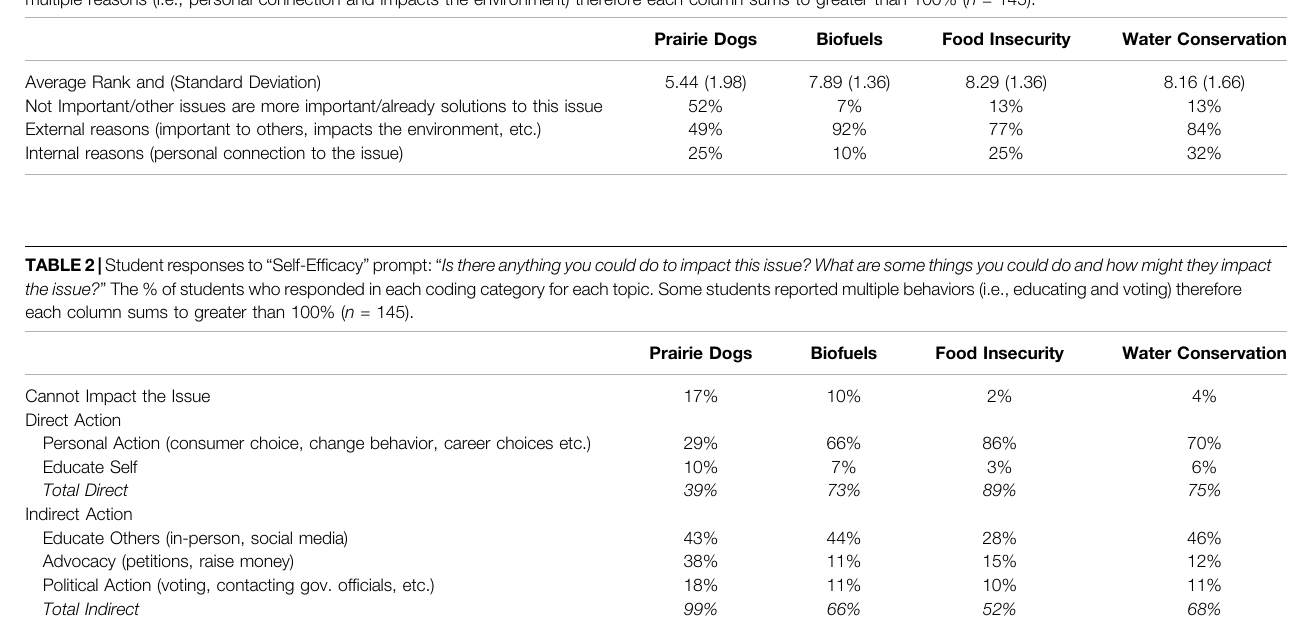
TABLE 1| Student responses to “ Importance ” prompt: “ Howimportant do youthink this issueis toyou personally? Rank the issue on ascale of1 (not at all important) to 10 (one of the most important issues). Why? ” The mean rank and the % of students who responded in each coding category for each topic. Some students reported multiple reasons (i.e., personal connection and impacts the environment) therefore each column sums to greater than 100% ( n (cid:1) 145).